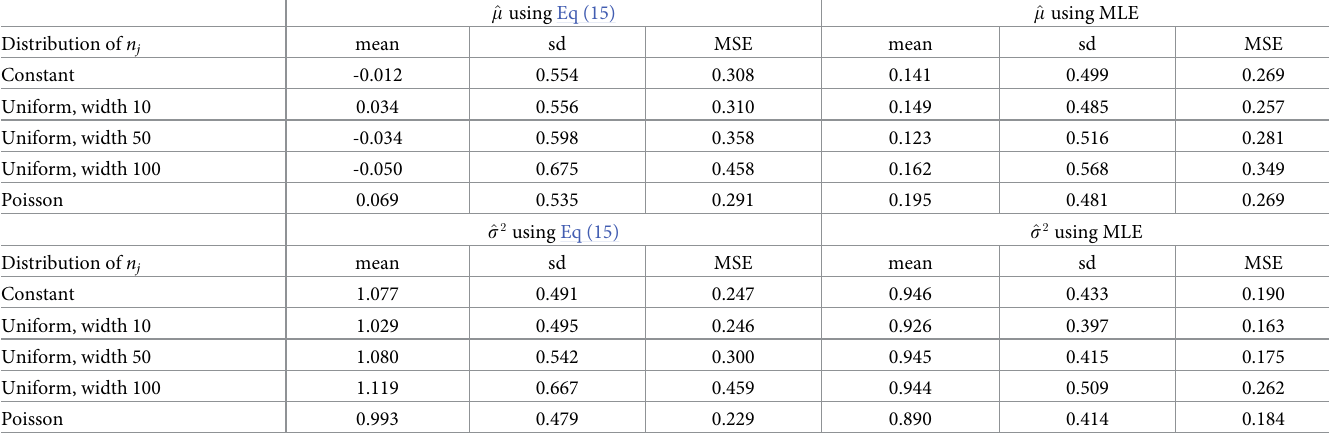
Table 2. Comparison of the estimates for the mean and variance of the normal distribution using Eq (15) versus maximum likelihood estimation, from 100 simula- tions with true value of μ = 0 and σ 2 = 1. ^ m using Eq (15) ^ m using